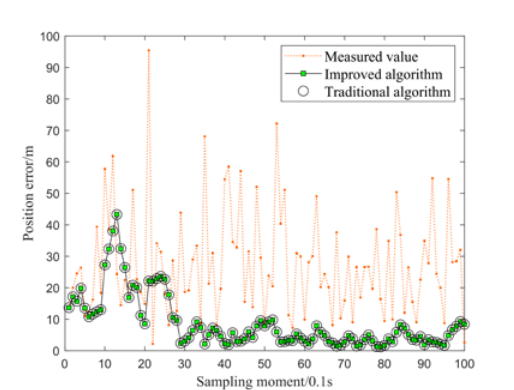
Fig. 4. Target tracking trajectory map.